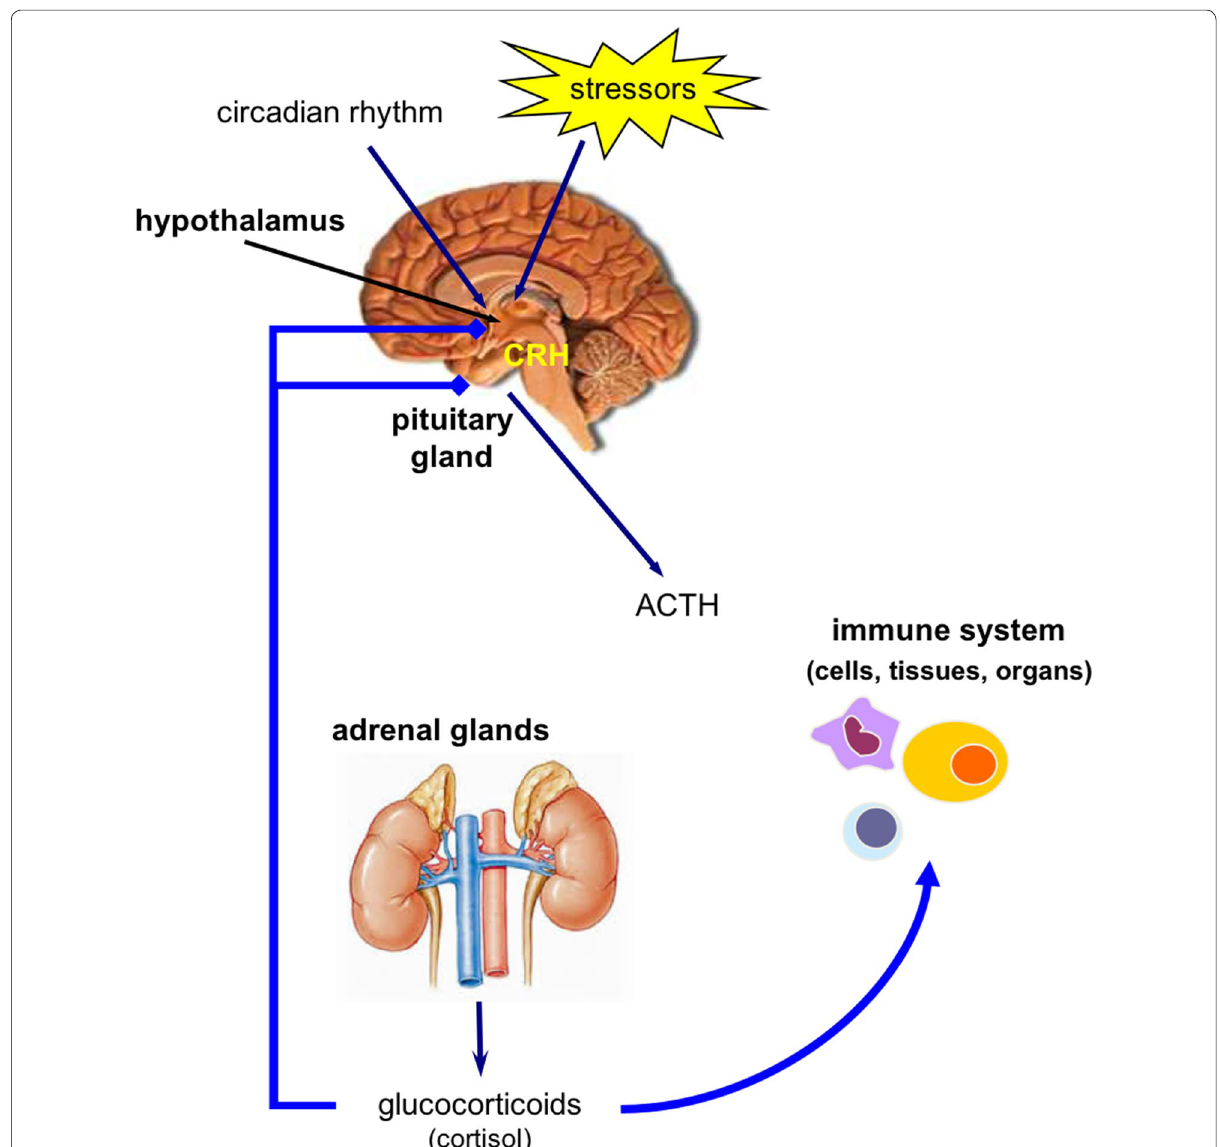
Fig. 1 The hypothalamic–pituitary–adrenal axis. Stress stimuli induce the production of CRH by the hypothalamus. CRH induces the production of ACTH by the pituitary gland which stimulates the production of glucocorticoids (cortisol) in the adrenal gland cortex. Cortisol acts on many cells, tissues, and organs including the immune system. The excessive release of cortisol as well as proinflammatory cytokines have a negative feedback on the central nervous system by inhibiting this circadian cycle. CRH corticotrophin releasing hormone, ACTH adrenocorticotrophin